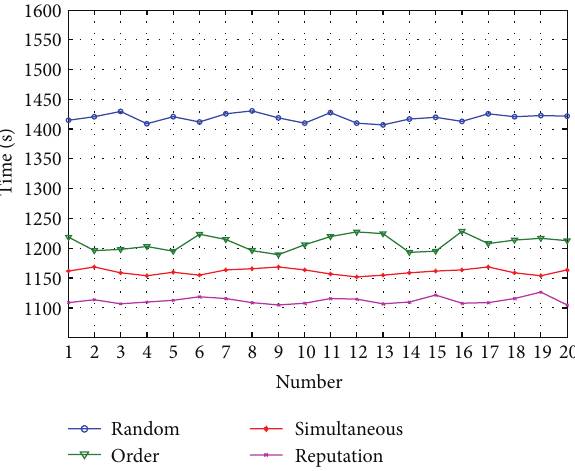
Figure 9: Biped-robot experimental apparatus.